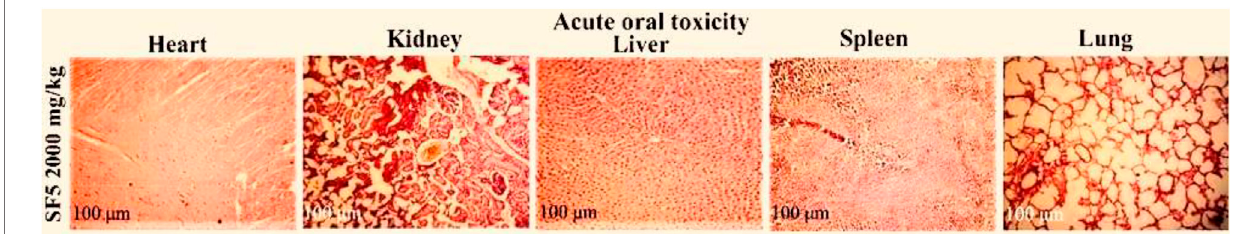
FIGURE 3 | Histopathology of the selected organs in acute oral toxicity (2,000 mg/kg).